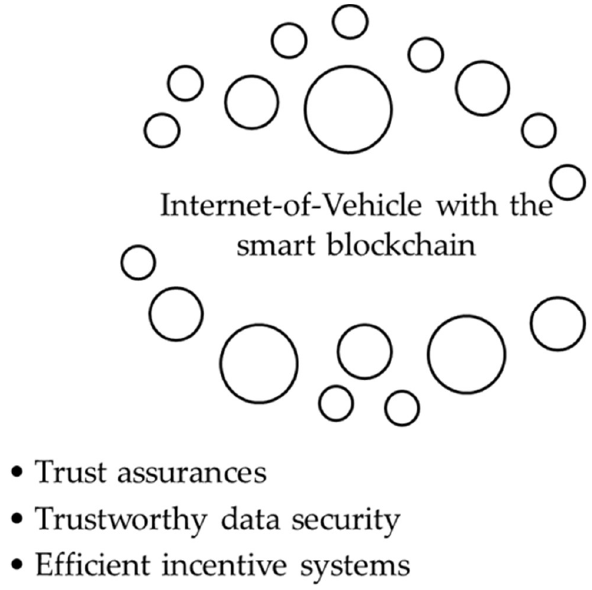
Figure 10. Effects of smart blockchain on IoV.